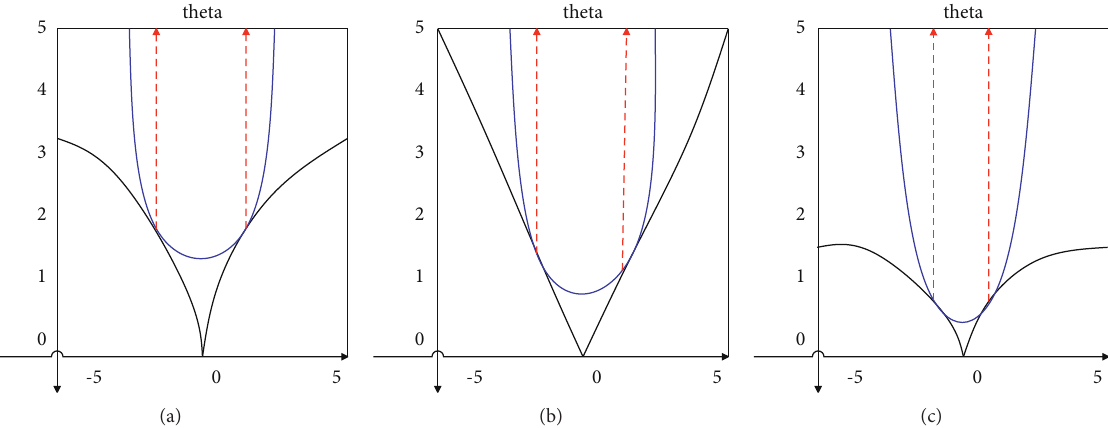
Figure 1: Three penalty functions and their quadratic approximation. (a) Hard threshold penalty function. (b) L1 penalty function. (c) SCAD penalty function λ � 2 and a �